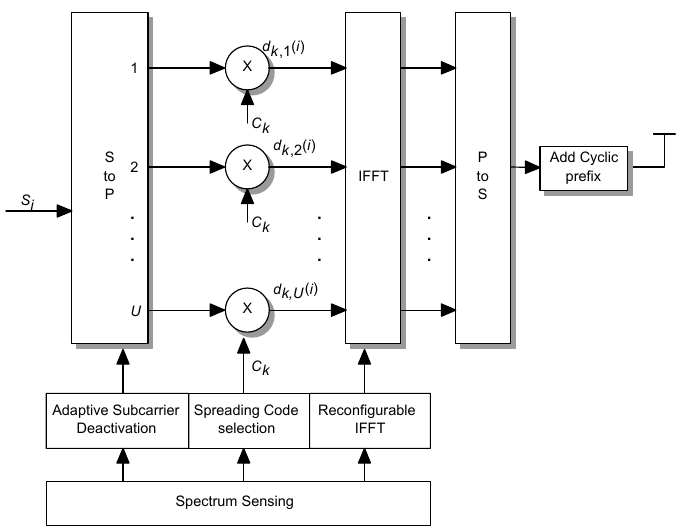
Figure 7. Reconfigurable MC-DS-CDMA